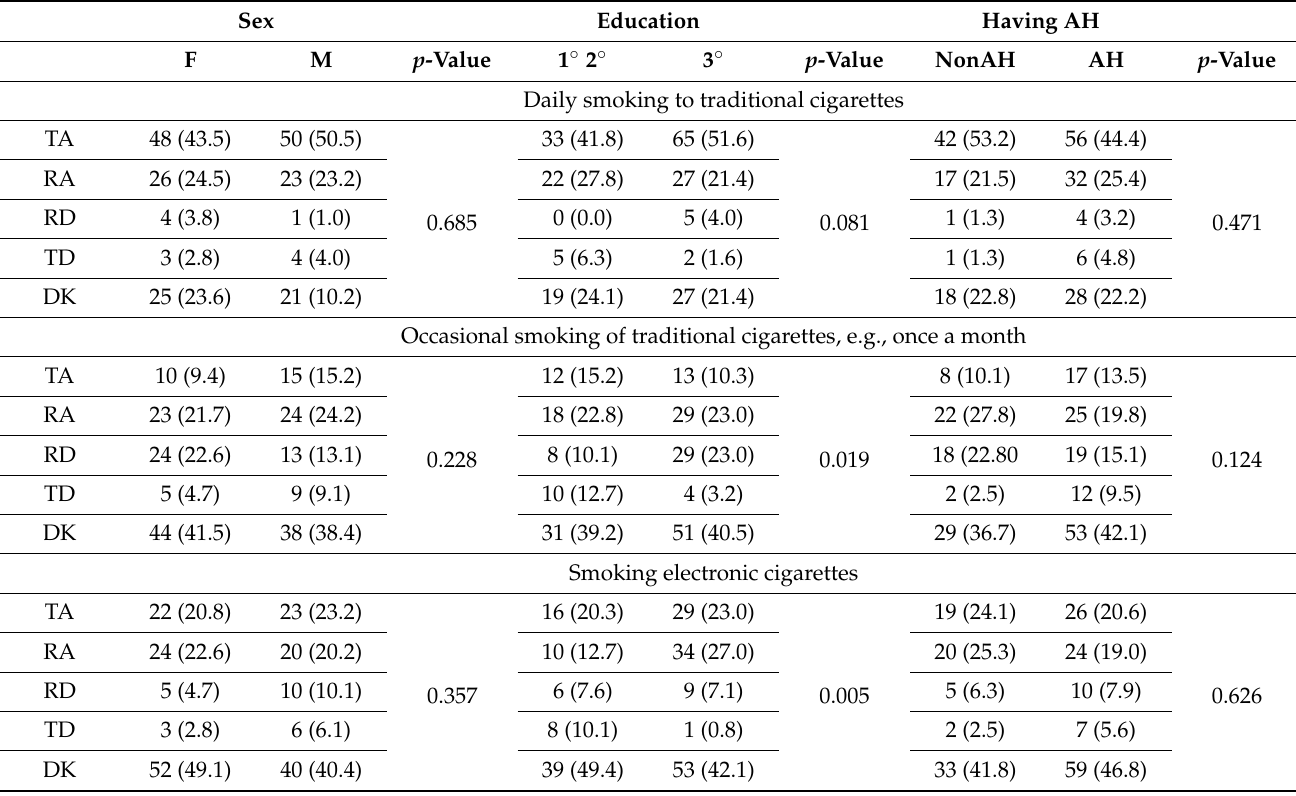
Table 6. Smoking cigarettes as a factor that increases the incidence of hypertension by gender, education, and having hypertension (N =